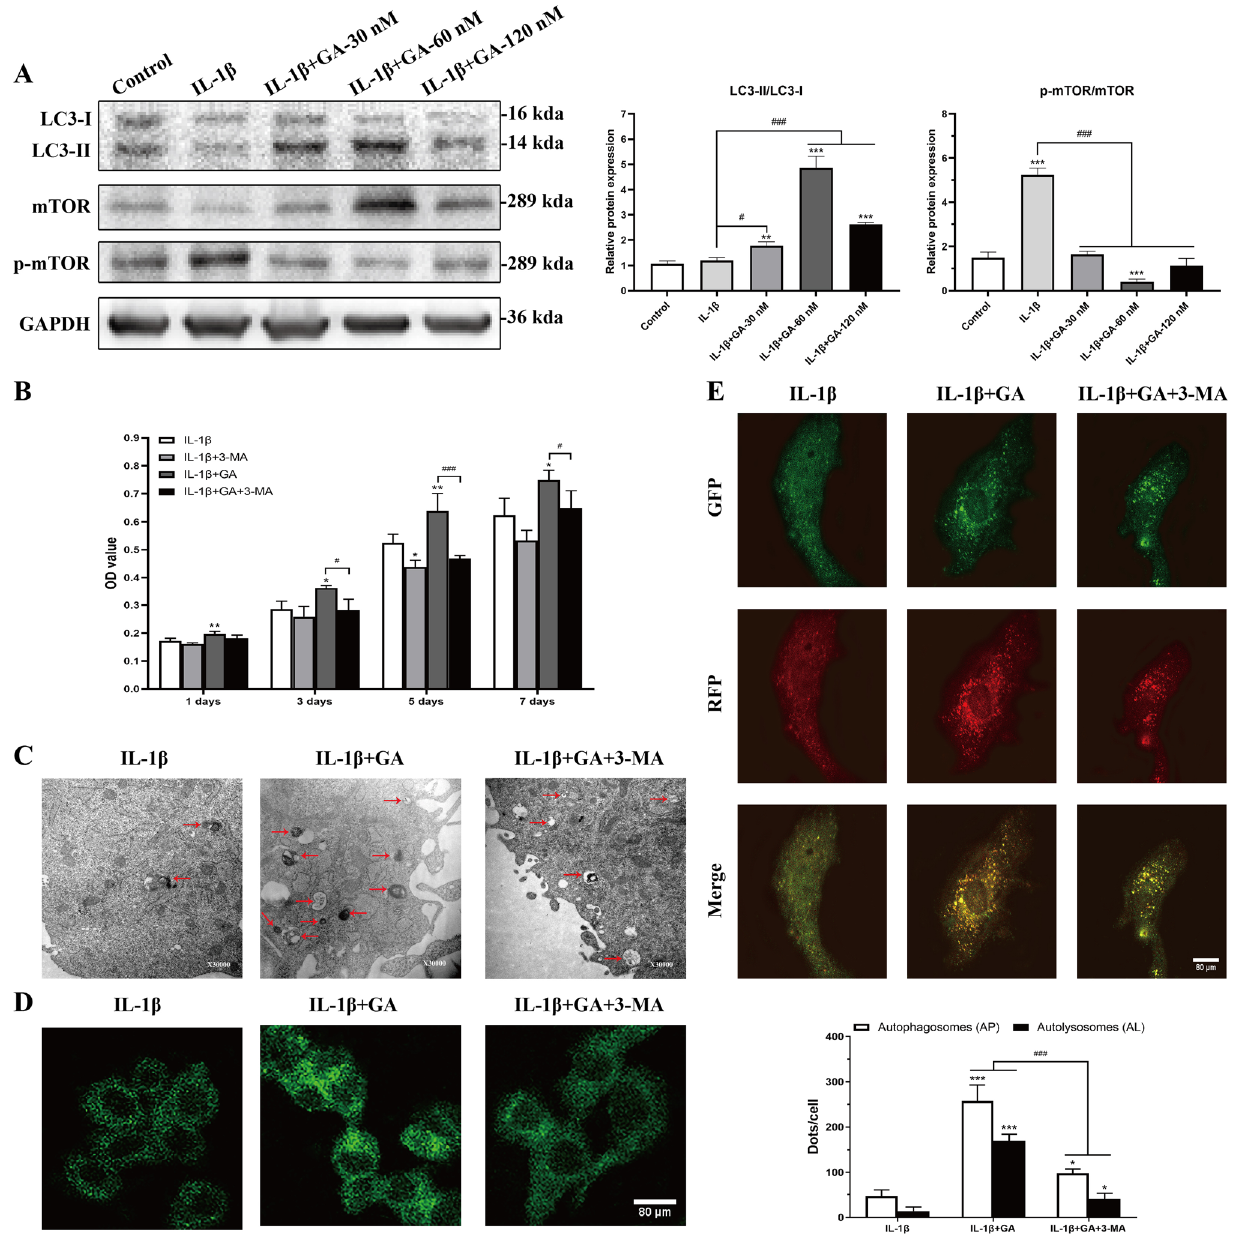
Figure 4. Effects of His6-GABARAP on autophagic flux in BMSCs in vitro. ( A ) Western blot of LC3, mTOR, and p-mTOR in different groups were detected respectively and the semi-quantitative analysis of LC3 II/I ratio and mTOR/p-mTOR are shown. ( B ) MTT assay were applied to detect the cell proliferation at days 1, 3, 5, and 7. ( C ) TEM images of the autophaghic change in BMSCs. Single arrow: autophagolysosome and autophagosome with double membrane structure. Original magnification × 30,000. ( D ) Representative pictures of MDC staining. Scale bar, 80 μm. ( E ) Representative pictures of immunofluorescent BMSCs expressing mRFP-GFP-LC3. GFP dots are green, and mRFP dots are red. Scale bar, 80 μm. And Semi-quantitative analysis of autophagosomes (AP; yellow dots in merged images) and autolysosomes (AL; red only dots in merged images). Control (without IL-1β); IL-1β (with 10 ng/mL IL-1β); IL-1β + 3-MA (with 10 ng/mL IL-1β and 3-MA); IL-1β + GA (with 10 ng/ mL IL-1β and 60 nM His6-GABARAP); IL-1β + GA + 3-MA (with 10 ng/mL IL-1β, 60 nM His6-GABARAP, and 3-MA). Values are presented as means ± SD, n = 3. * p < 0.05, ** p < 0.01, *** p < 0.001 relative to the control group; # p < 0.05, ## p < 0.01, ### p < 0.001 relative to the IL-1β